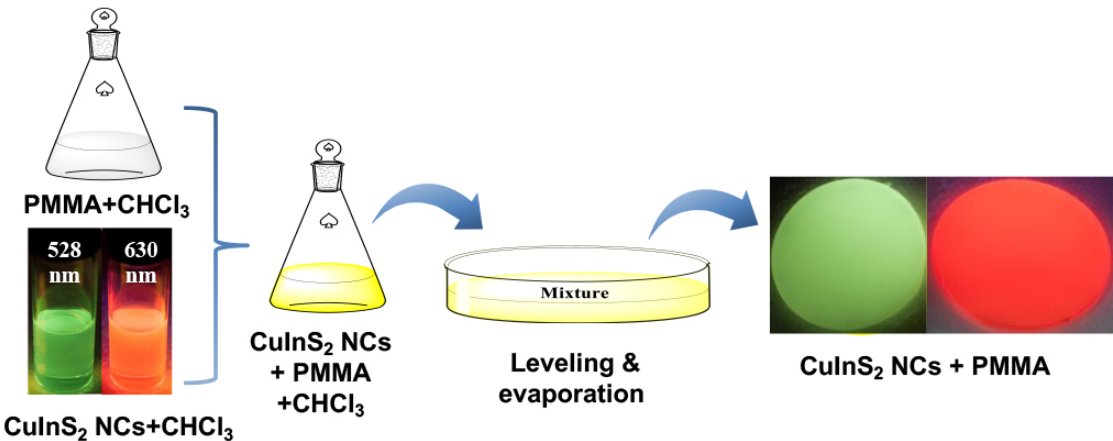
Figure 1. Schematic illustration of the fabrication of CuInS 2 NC-embedded PMMA composite films.